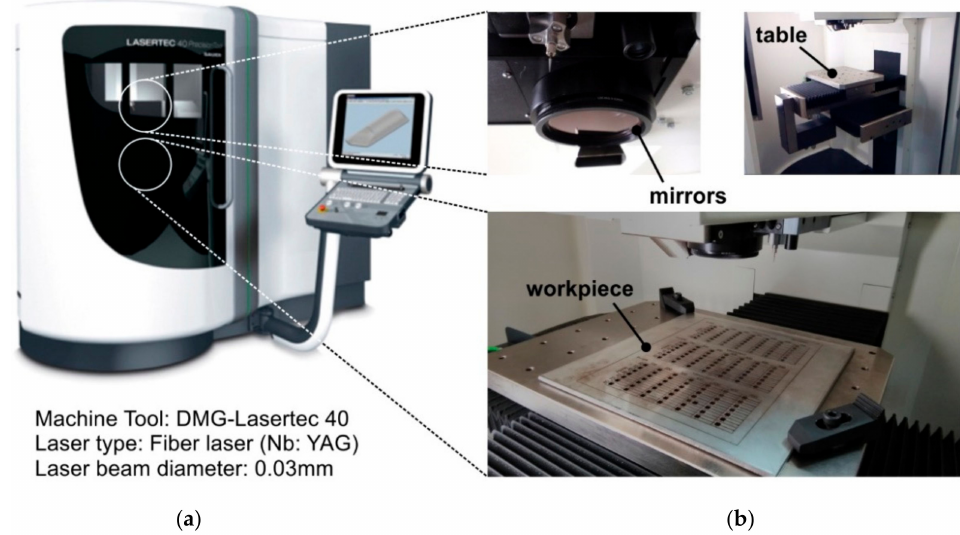
Figure 2. Laser engraving machine DMG MORI Lasertec 40 ( a ) Exterior view; and ( b ) interior view.